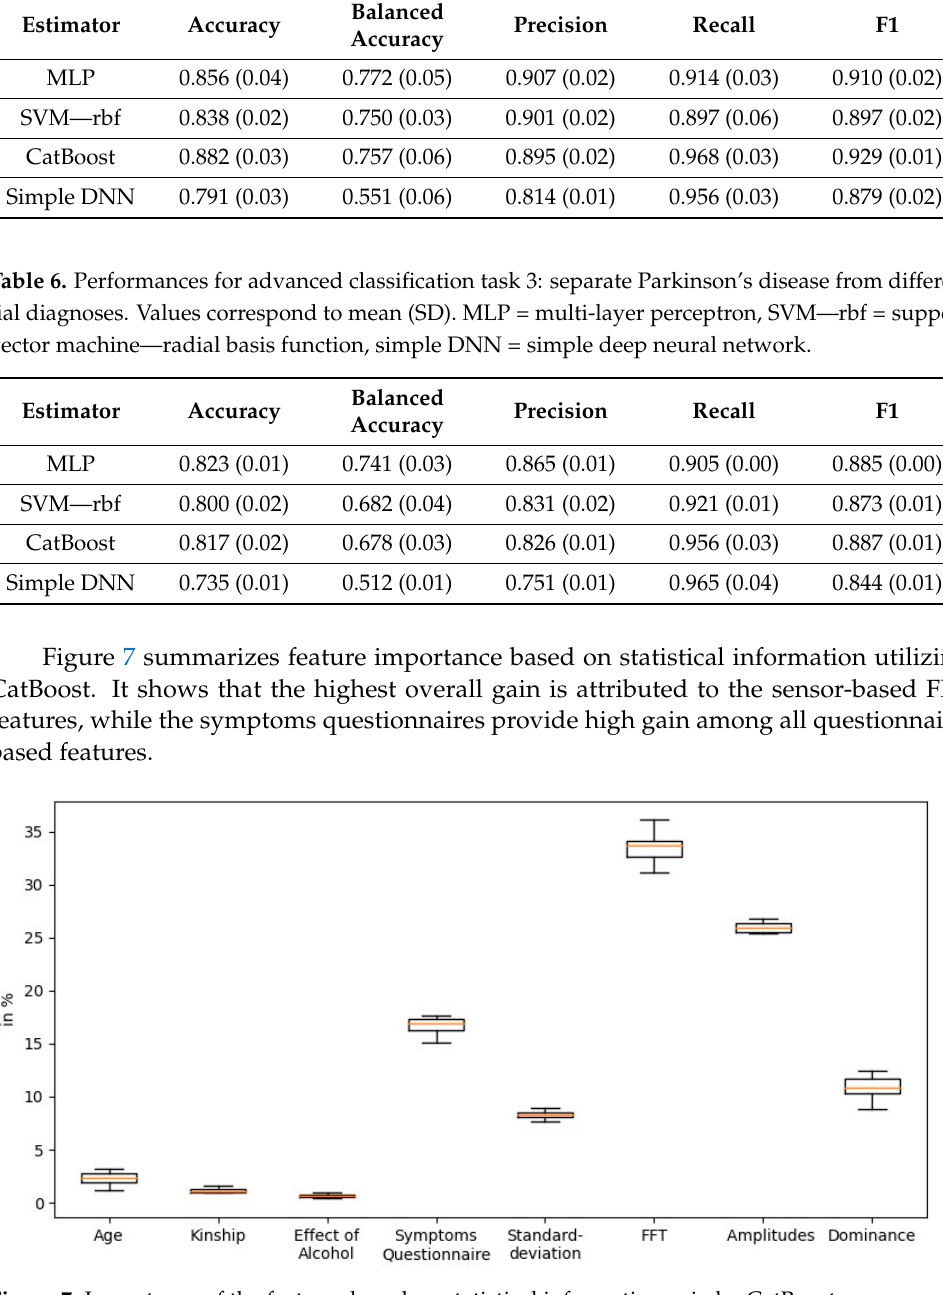
Figure 7. Importance of the features based on statistical information gain by CatBoost. Among the different combinations of DL architectures, the best-performing architec- ture included a simple dense neural network that could only reach balanced accuracies lower than 60%. It is noteworthy that the inclusion of LSTMs consistently weakened the classification performance and therefore did not participate in our final DL architecture.